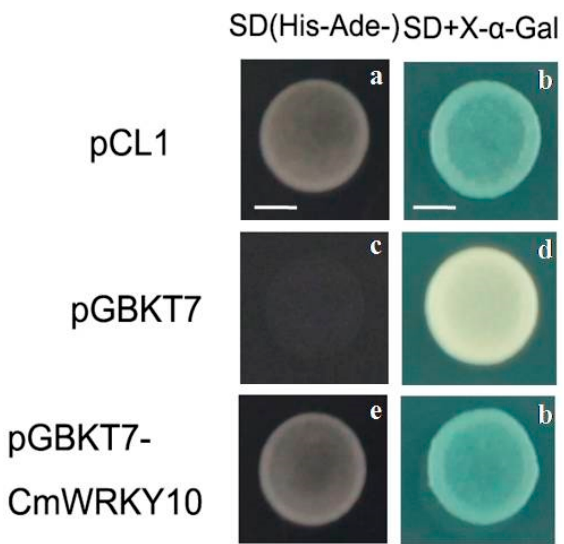
Figure 2. An assessment of the transcription activation assay of CmWRKY10 using the yeast strain and a yeast one-hybrid system. The first column ( a , c , e ) shows the growth of transformants on SD/-His-Ade selection medium, where the growth of pCL1 ( e ) and empty vector pGBKT7 ( c ) represents the positive and negative control, respectively, representing the transcriptional activity of CmWRKY10; The second column ( b , d , f ) represents the growth of the same set of colonies in the presence of X- α -gal. Scale bars = 4 mm.